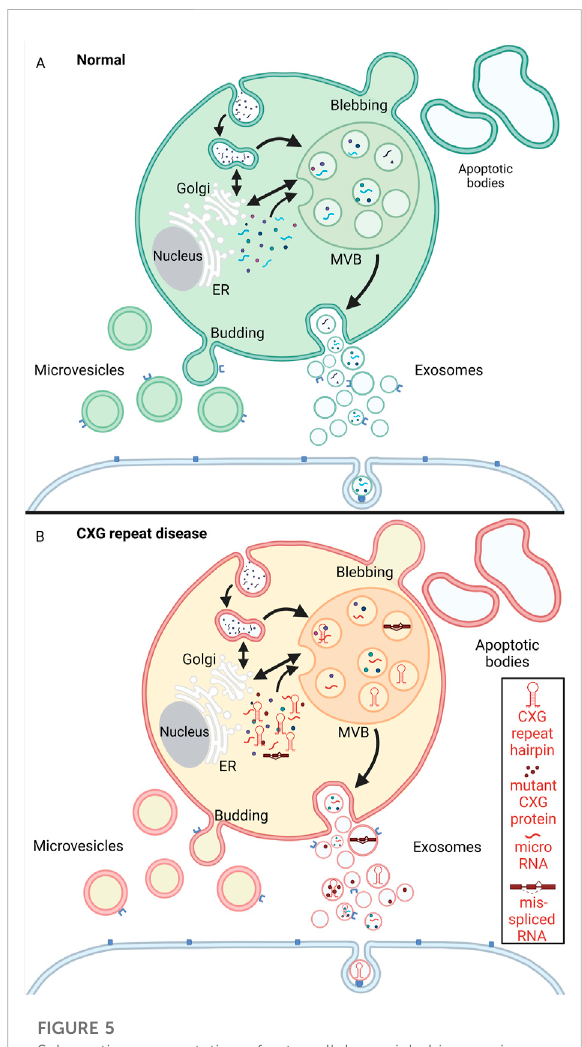
FIGURE 5 Schematic representation of extracellular vesicle biogenesis under physiological conditions (A, green) and CXG repeat disease cells (B, red/yellow). (A) Microvesicles are released to the extracellular space by budding from the plasma membrane. Apoptotic bodies arise from membrane protrusions (blebbing) during fragmentation of an apoptotic cell (ES, 2007; Akers et al., 2013; Povea-Cabello et al., 2017; Tricarico et al., 2017). Exosomes are formed bya multistep process that startswith endocytosis (the inward budding of the cell membrane and internalization of cargo into early endosomes). The early endosomes mature into multivesicular bodies (MVBs). By invagination of the MVB membrane intraluminal vesicles (ILVs) are formed. During this process, cytosolic components like proteins, RNAs and lipids are incorporated into ILVs. The ILVs are then released as exosomes from the MVBs into the extracellular space by fusion with the plasma membrane. The exosomes can then be taken up by neighboring cells via endocytosis. (B) In the context of CXG repeat diseases, pathogenic mutant RNA (hairpin, red), micro RNA, mis- spliced RNA and aggregating proteins (red dots) are passed on to neighboring cells via the exosomes. Created with